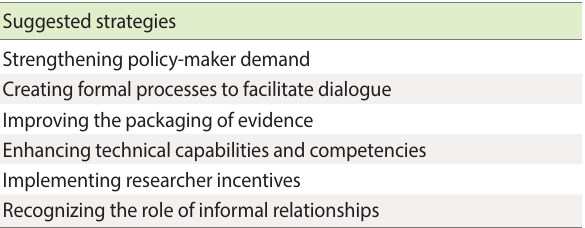
Table 1. Suggested strategies to promote evidence-based public health